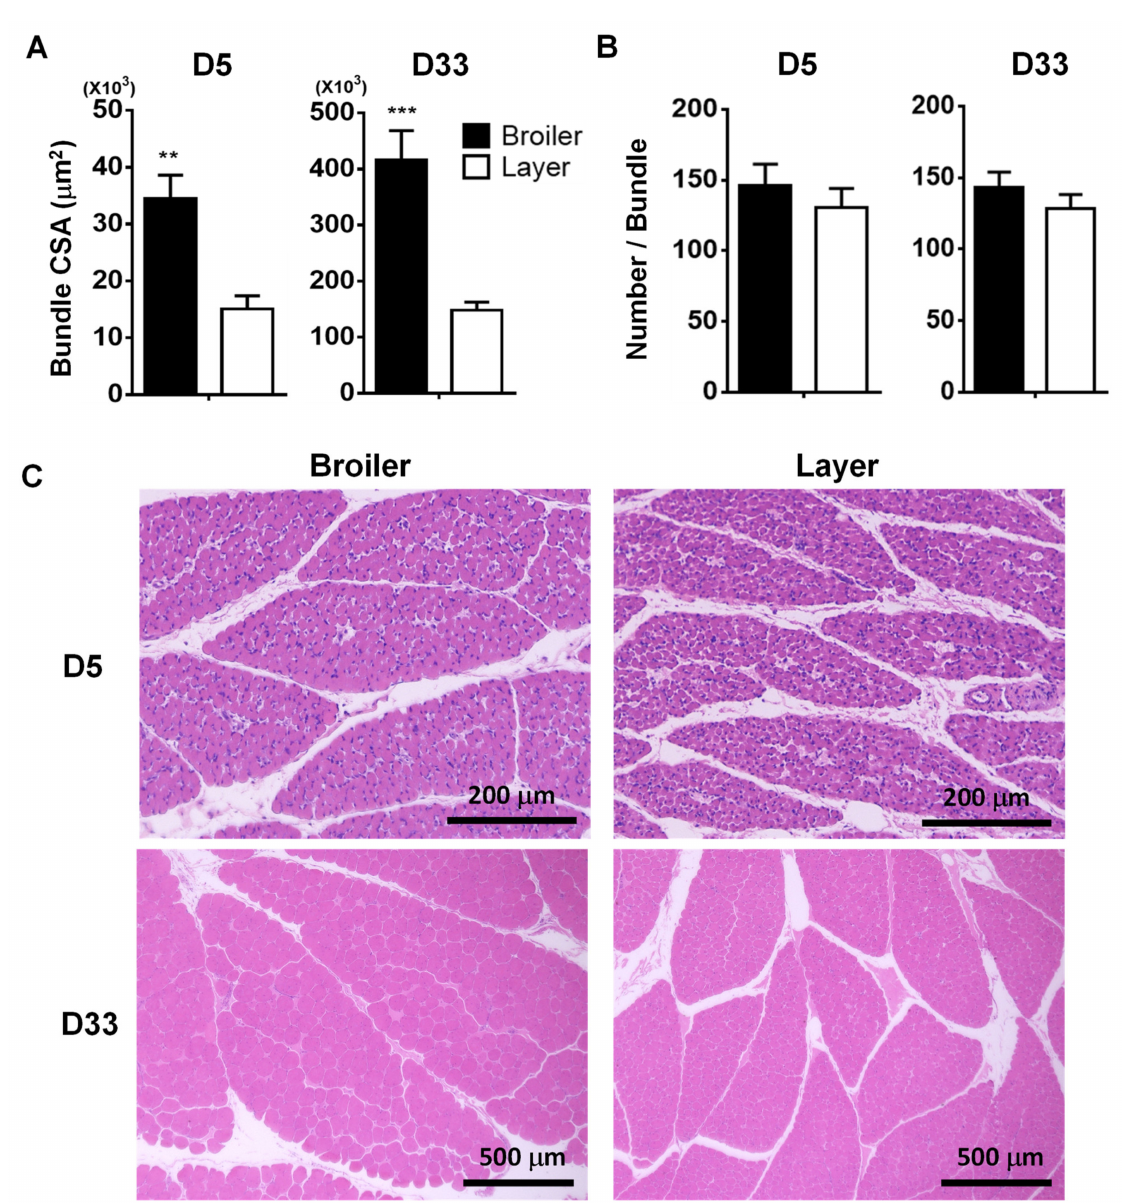
Figure 3. Morphological differences in the bundle of pectoralis major muscles at D5 and D33